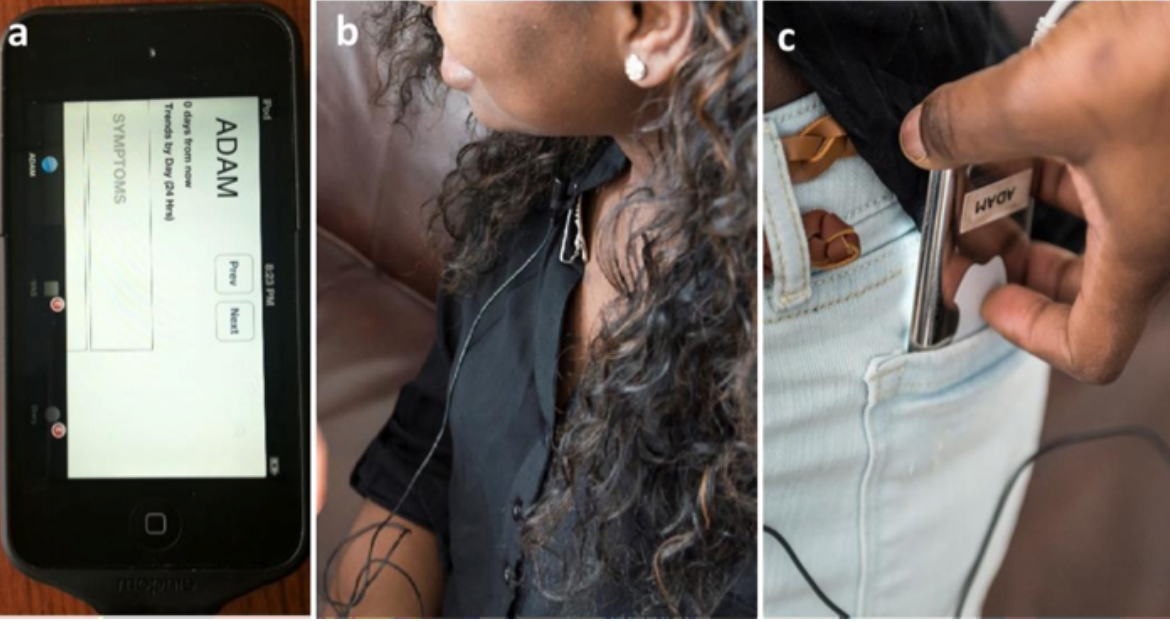
Figure 6. Images of the automated device for asthma monitoring (ADAM) with an external battery attached (a), and a teen wearing the device (b and